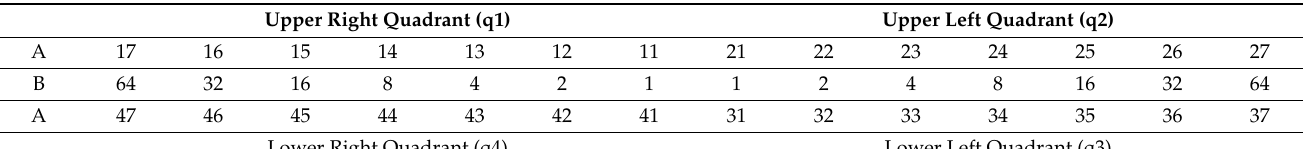
Table 1. Representation of the human dentition consisting of 32 teeth, divided into 4 quadrants (q1, q2, q3, q4). A: tooth numbering according to the FDI World Dental Federation notation. B: application of binary arithmetic to assign unique values to each tooth agenesis (Van Wijk and Tan, 2006). Upper Right Quadrant (q1) Upper Left Quadrant